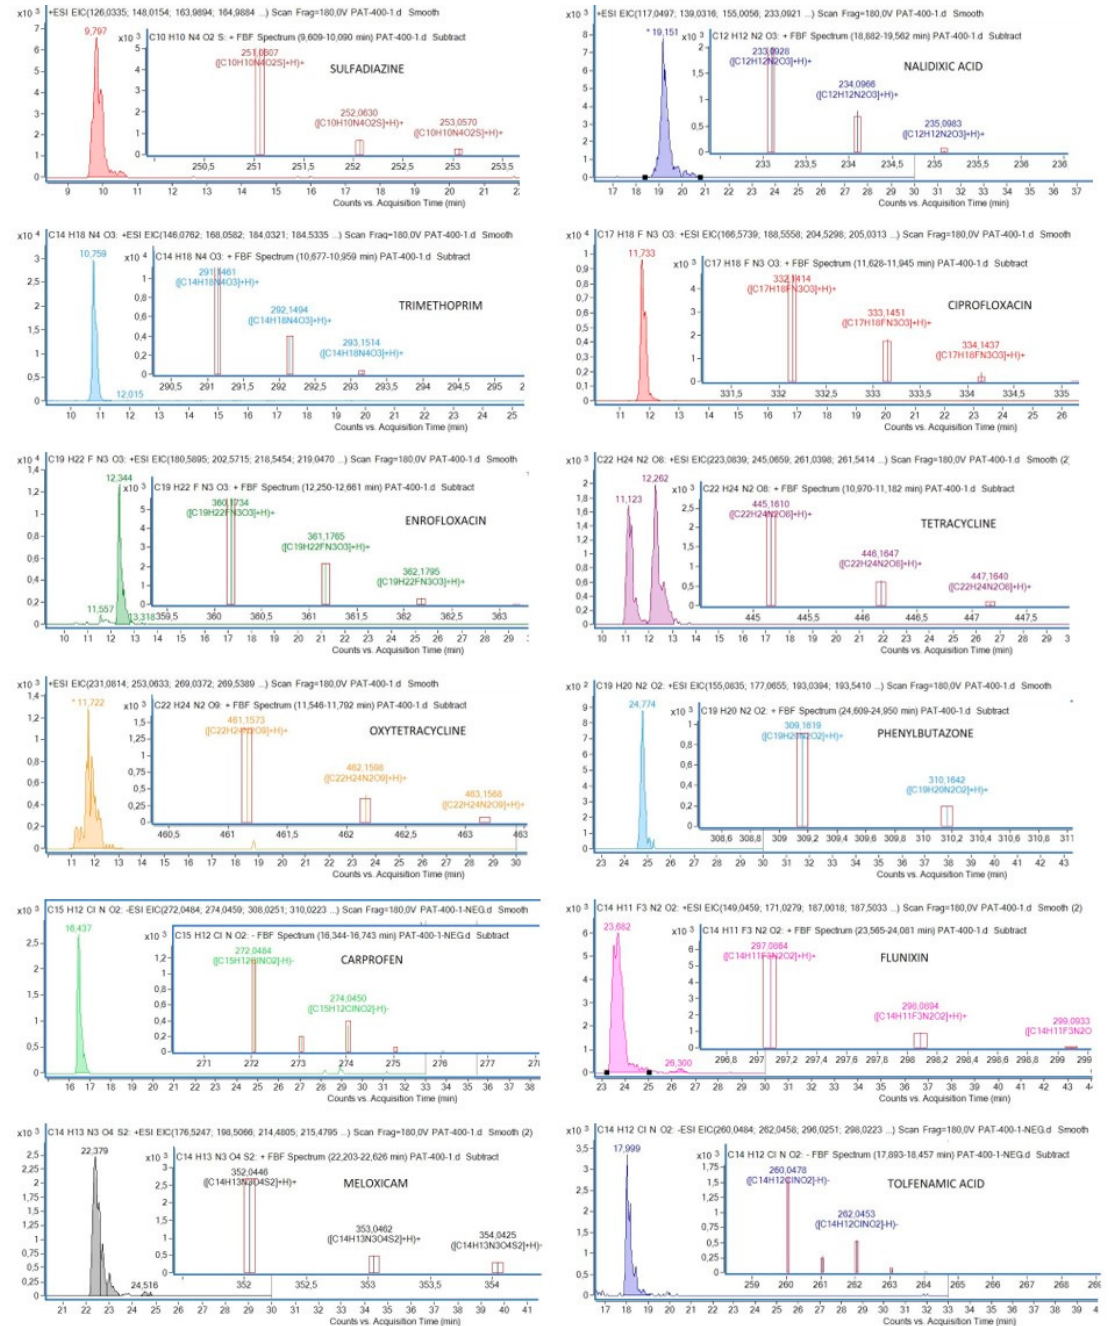
Figure 1. Chromatograms of each antibiotic and nonsteroidal anti-inflammatory drug (NSAID) and their mass spectra, detected by the validated method.